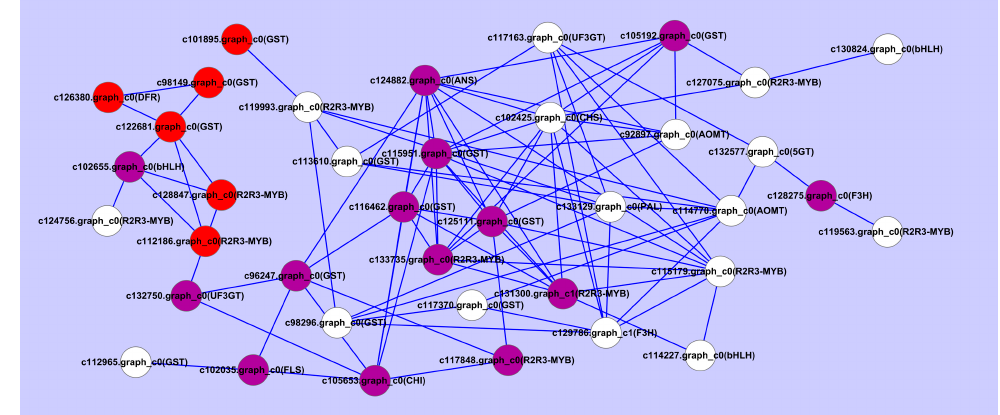
Figure 8. A co-expression network of the DEGs involved in pigmentation. The white, purple, and red circles represent the genes with the highest expression levels in the P. ostii , P. rockii and F1 progeny petals, respectively.